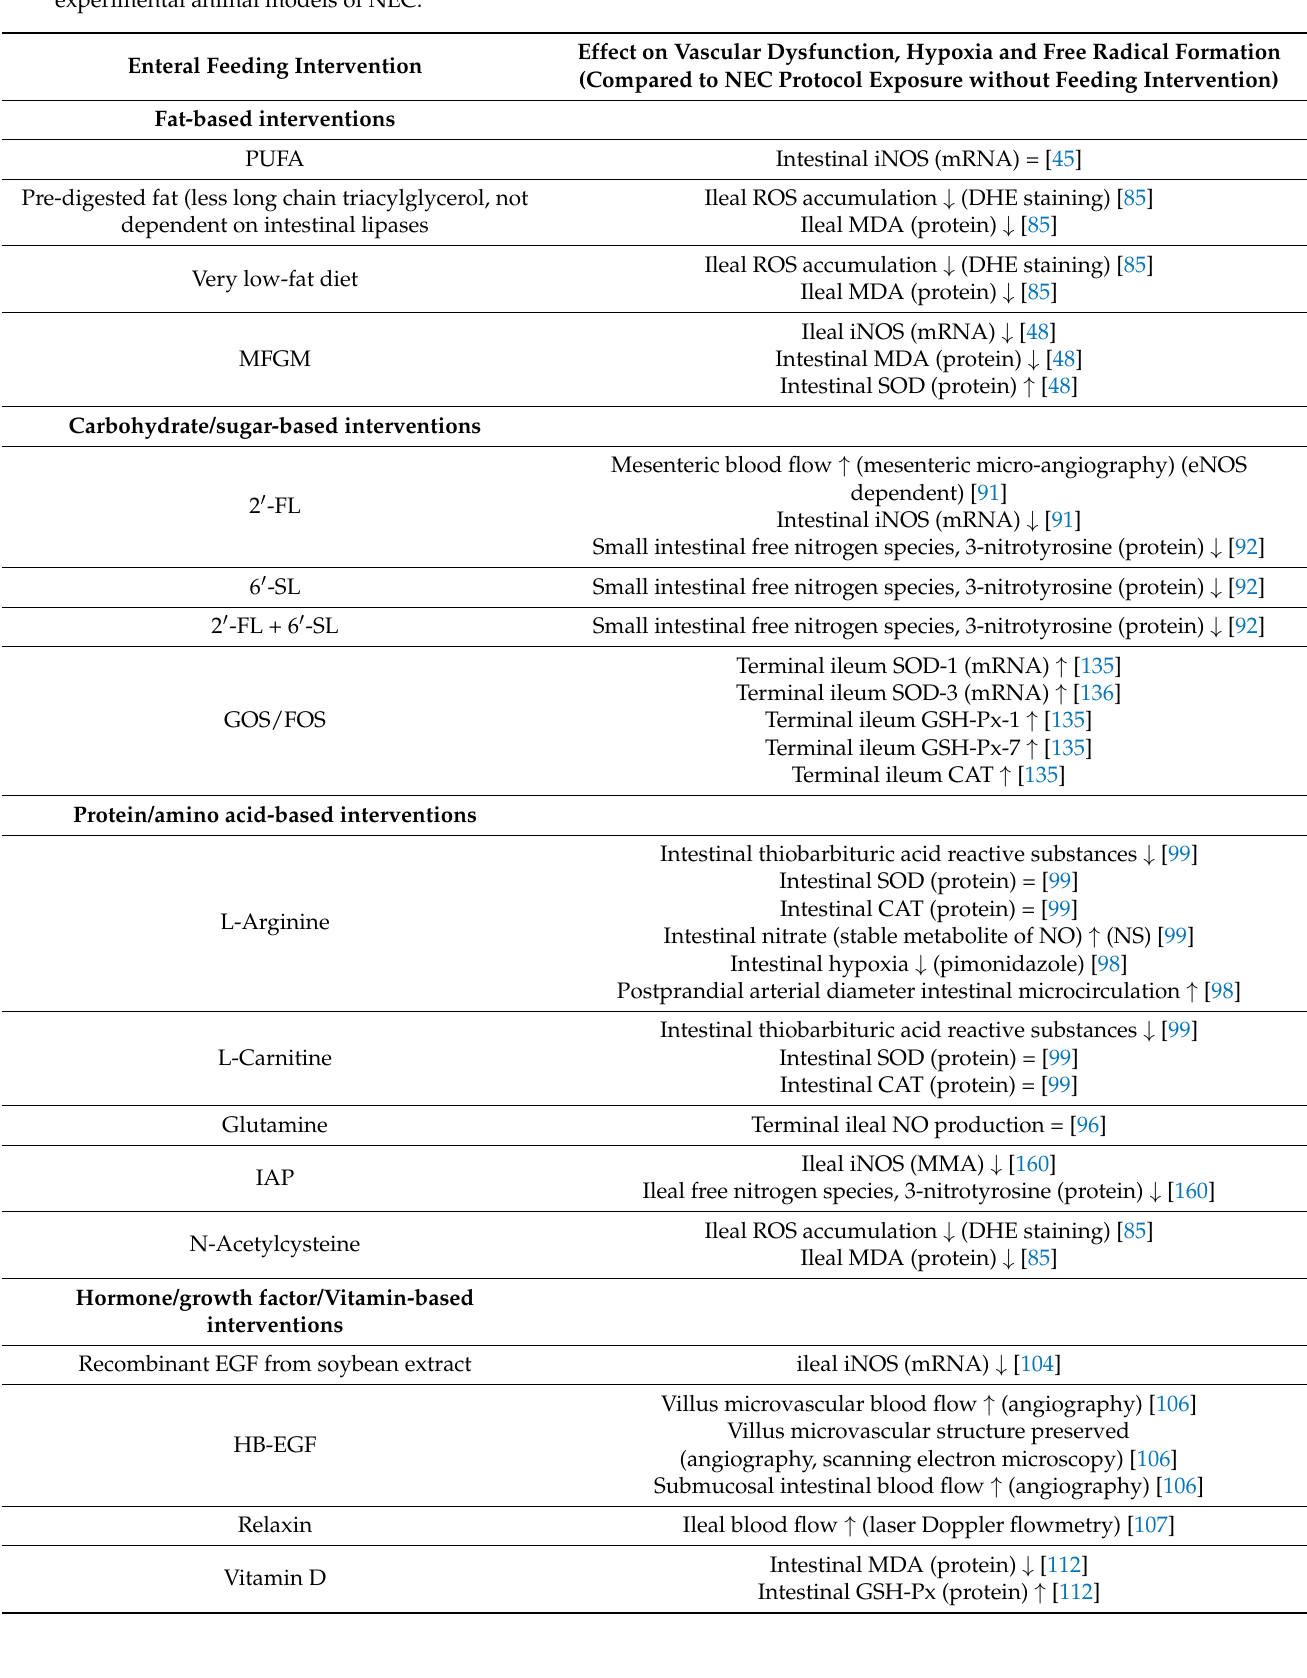
Table 9. Effect of enteral feeding interventions that reduce vascular dysfunction, hypoxia and free radical formation in experimental animal models of